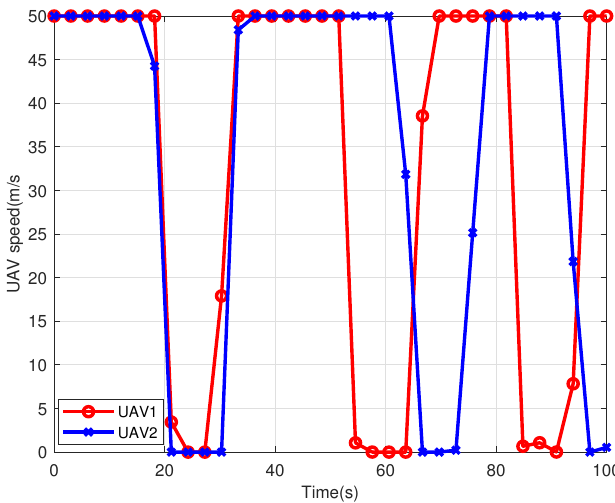
Figure 7. The UAV speed changes within the flight duration T = 100 s in multi-UAV scenario.